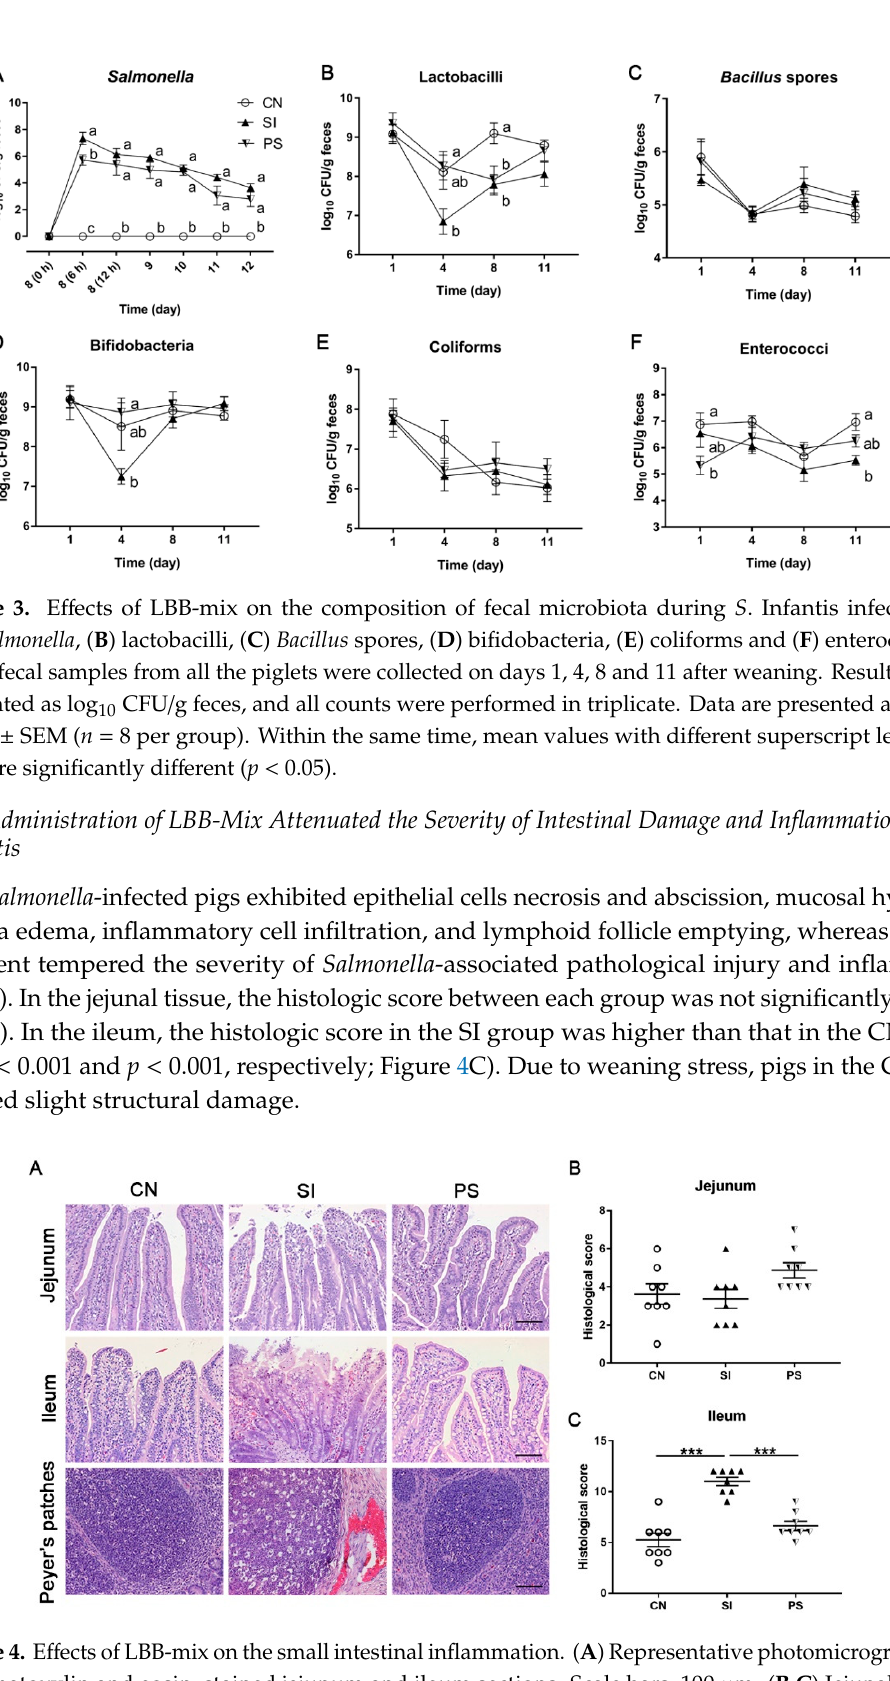
Figure 4. E ff ects of LBB-mix on the small intestinal inflammation. ( A ) Representative photomicrographs of hematoxylin and eosin–stained jejunum and ileum sections. Scale bars, 100 µ m. ( B , C ) Jejunal and ileal histologic scores. Data are presented as the mean ± SEM ( n = 8 per group). * p < 0.05; ** p < 0.01; *** p <